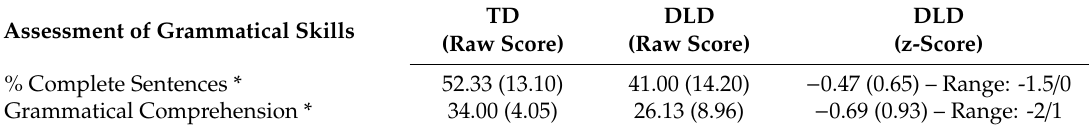
Table 6. Results (means and SDs) of the assessment of grammatical production and comprehension skills in the two groups of participants. For children with DLDs, both raw scores and z-scores with respect to normative data are reported in separate columns. For z-scores, ranges are also reported. The asterisk (*) shows when the group-related di ff erence in raw scores is significant.